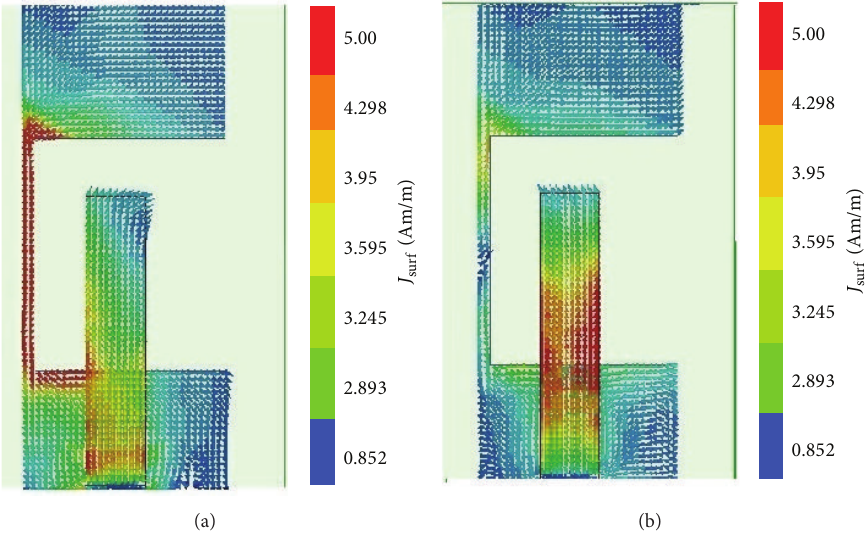
Figure 6: Surface current distribution of the proposed antenna at (a) the first band at 2.4 GHz and (b) the second band at 5.6 GHz.